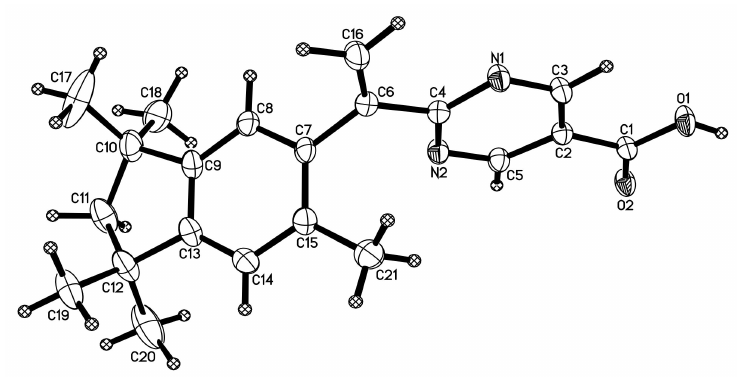
Figure 6. X-ray crystal structure of 32